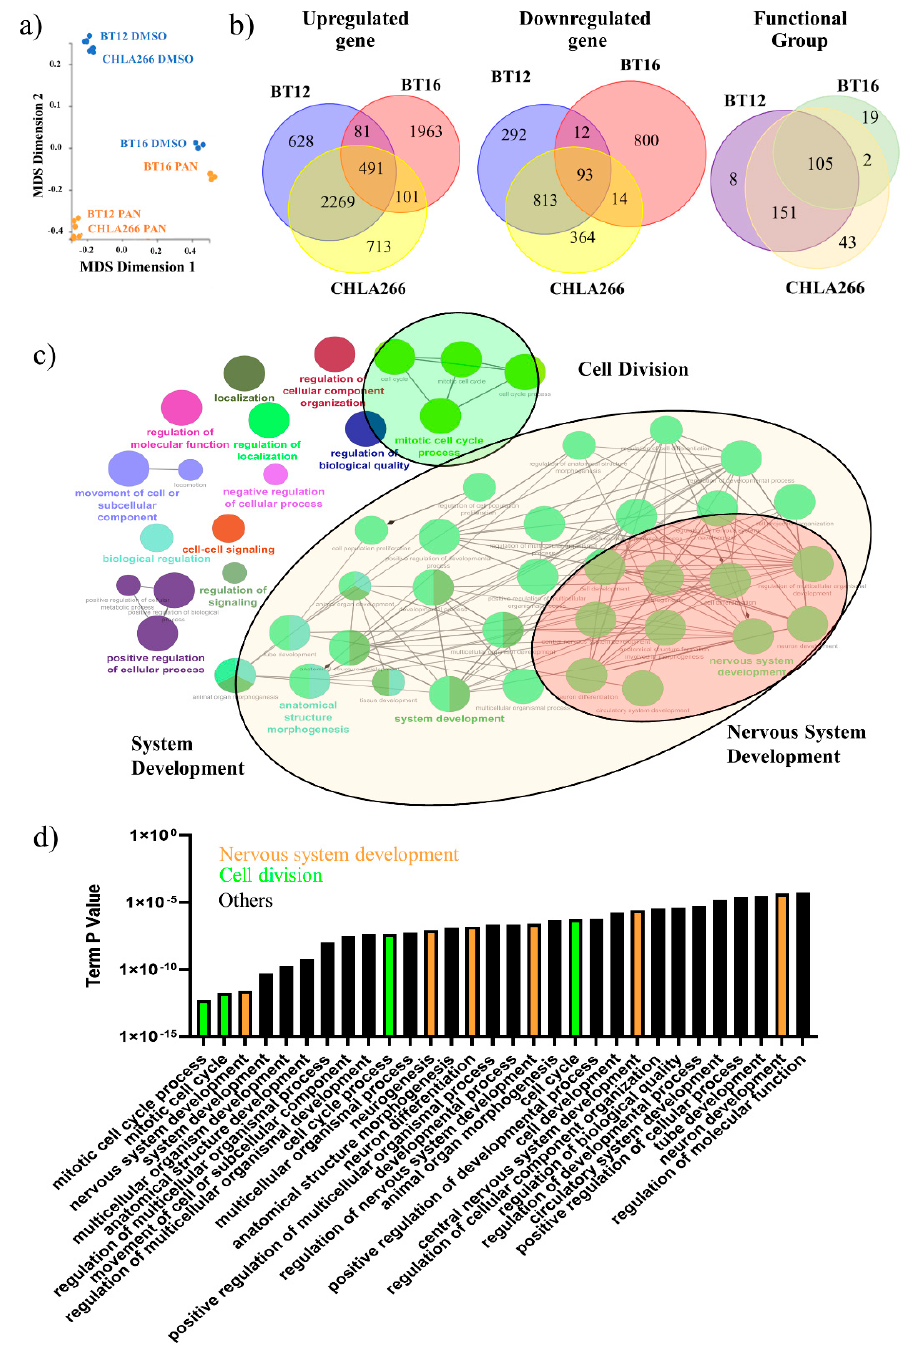
Figure 3. Global gene expression analysis of human ATRT cell lines treated with panobinostat. ( a ) Multidimensional scaling (MDS) plot of BT12, BT16 and CHLA266 treated with DMSO or 10 nM panobinostat (PAN) for 21 days ( n = 3). ( b ) Venn diagram of differentially expressed genes and functional groups in BT12, BT16, and CHLA266 treated with 10 nM panobinostat ( n = 3). ( c ) Gene Ontology network map for conserved differentially expressed genes among BT12, BT16 and CHLA266 treated with 10 nM panobinostat for 21 days (FDR < 0.05; LogFc < − 2 or >2; pV < 0.05). ( d ) Most significant functional groups associated with conserved differentially expressed genes among BT12, BT16 and CHLA266 treated with 10 nM panobinostat for 21